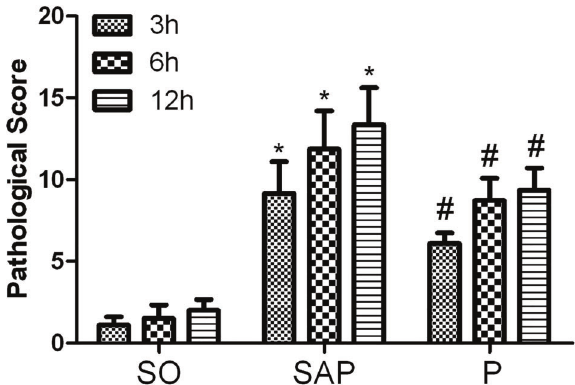
Figure 3. Analysis of pathological scores for pancreatic tissues at 3, 6, and 12 h. Data are reported as means ± SD.*P o 0.05 com- pared with the sham operation (SO) group; # P o 0.05 com- pared with the severe acute pancreatitis (SAP) group (ANOVA). P: pioglitazone group.